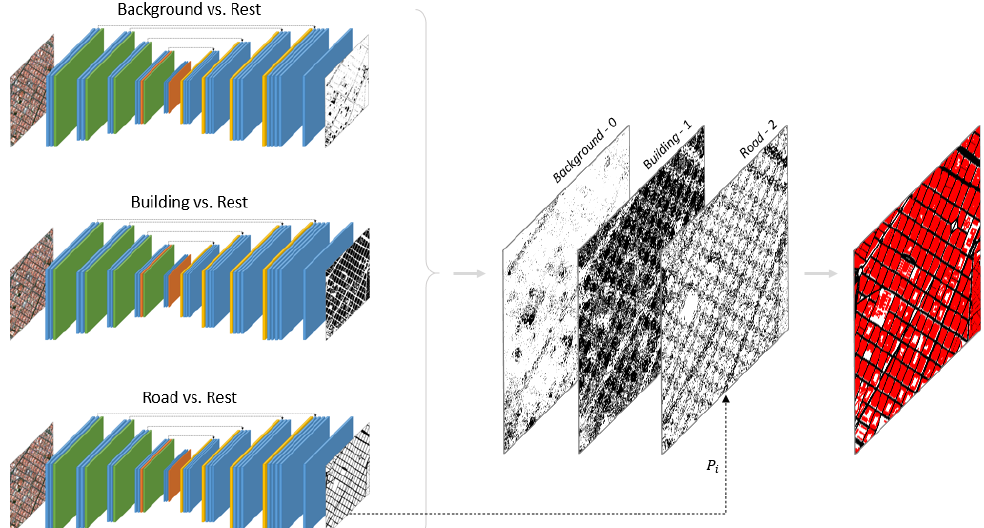
Figure 3. OVA decomposition scheme adapted to a multi-class semantic segmentation problem, including building footprints and road networks.